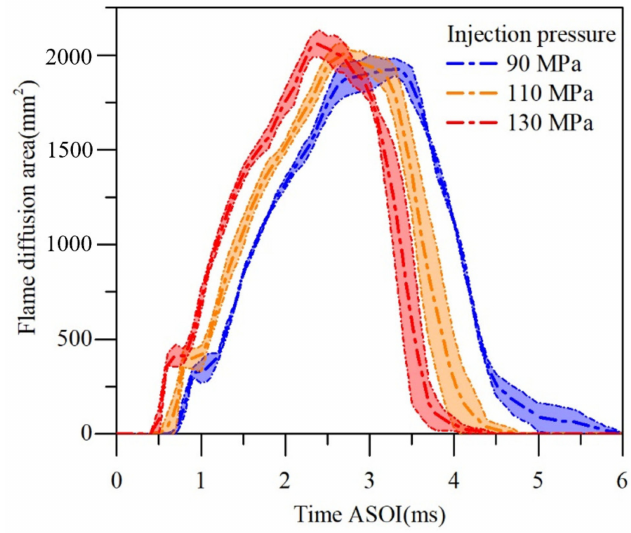
Figure 14. Flame di ff usion